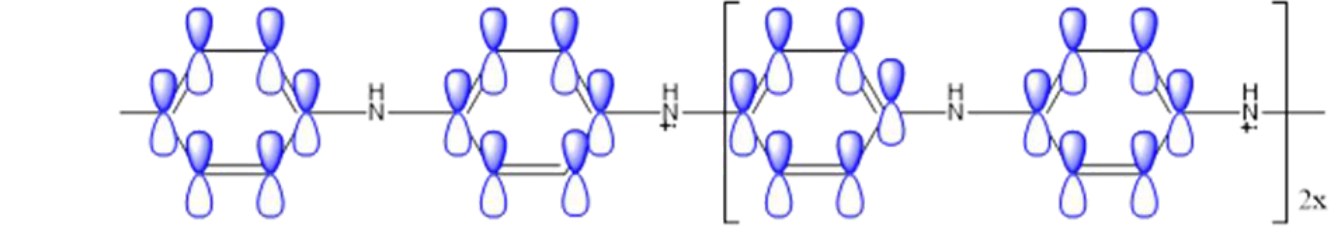
Figure 3. Schematic diagram of the π -system of PANI.